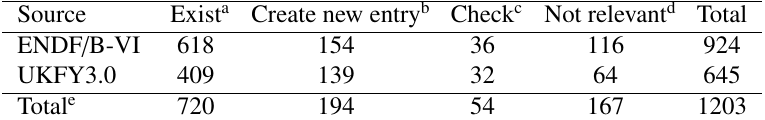
Table 1. The number of FPY references categorised during our assessment for those cited